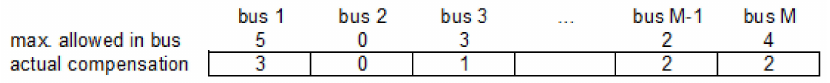
Figure 9. The encoding of the solutions used by the OCBA problem.